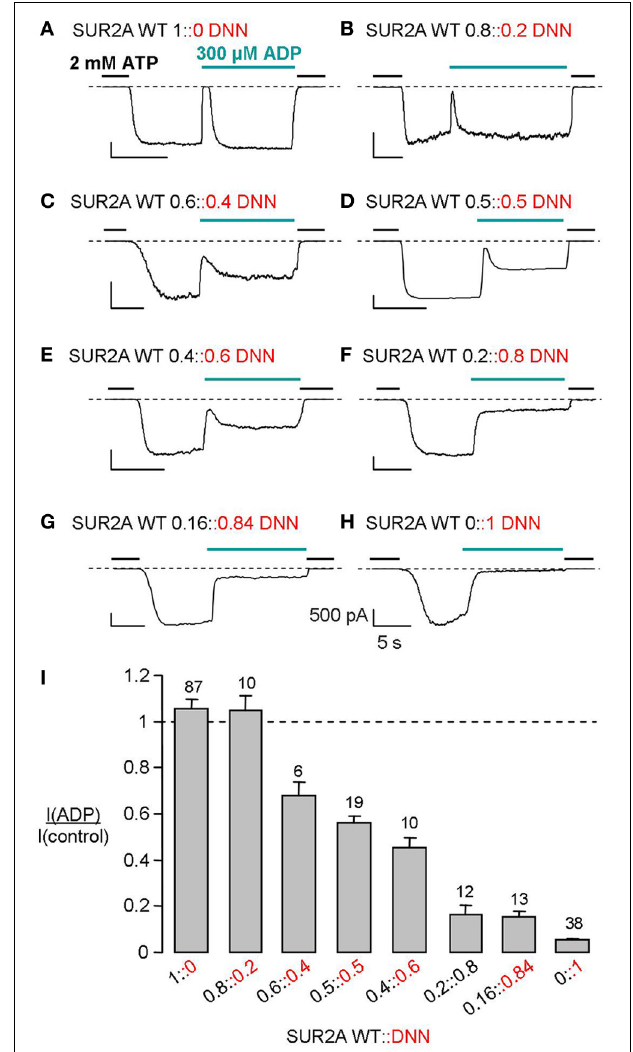
FIGURE 3 | Effect of ADP varies gradually with the ratio of WT to mutant SUR subunits. (A–H) MgADP responses of macroscopic currents recorded from Xenopus oocytes co-expressing Kir6.2 and the indicated mixtures of WT and mutant (DNN) SUR2A. (I) Average currents recorded in 300 µ M ADP normalized to the current measured before in nucleotide-free solution. Numbers above bars indicate the number of patches included in the averages. Normalization was necessary because of the intrinsic variability of the oocyte system. The amplitudes in nA of the currents measured in 0 ATP before ADP application were on average ( ± s.e.m): 4 . 4 ± 0 . 6 (WT 1::0 DNN), 1 ± 0 . 5 (WT 0.8::0.2 DNN), 1 . 3 ± 0 . 4 (WT 0.6::0.4 DNN), 5 . 3 ± 1 . 4 (WT 0.5::0.5 DNN), 1 . 4 ± 0 . 4 (WT 0.4::0.6 DNN), 1 . 6 ± 0 . 7 (WT 0.2::0.8 DNN), 3 . 5 ± 1 (WT 0.16::0.84 DNN), and 1 . 5 ± 0 . 3(WT